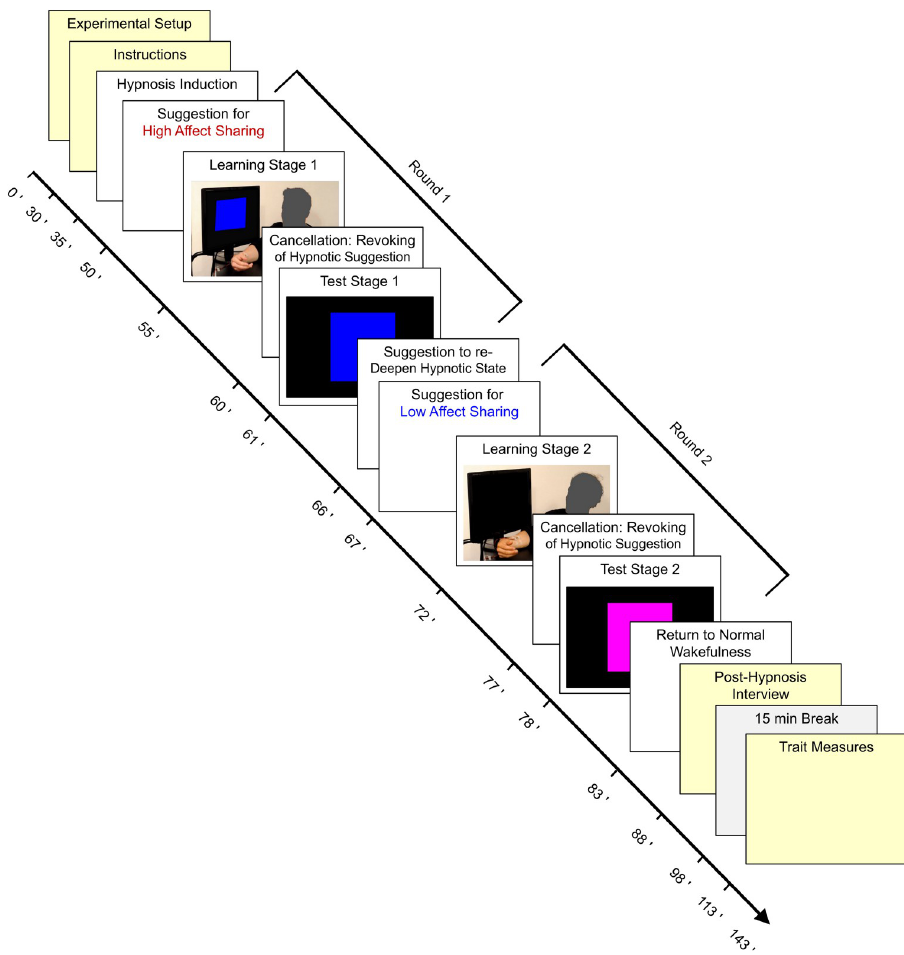
Fig 1. Overview of the experimental design and procedures. The vicarious fear conditioning paradigm consisted of a learning stage, in which the participant watched videos of a demonstrator receiving electric shocks paired with a predictive visual cue, followed by a test stage, in which an increased skin conductance response (SCR) to the cue compared to a control stimulus, in the absence of the demonstrator, indexed vicarious fear learning. Each participant completed this paradigm under two different hypnotic suggestions, which were administered before each learning stage to induce high or low affect sharing with the demonstrator (order counterbalanced across participants). Each suggestion was revoked (so-called “cancellation”) after the learning stage to bring the participants back to their habitual level of affect sharing before the start of the test stage. Eye tracking was used to assess eye gaze during the learning stages. The demonstrators’ heads have been masked in this Figure to protect their identity; participants saw their full face and expressions. a shock to the demonstrator (the demonstrator’s calm face following a CS- signaled the absence of the US). The videos are a well-tested stimulus set, which has been successfully used in previous studies on vicarious fear conditioning [2]. Video clips were presented at approximately 23.8 x 13.6˚ visual angle. Each video clip (trial) had a total duration of 9 s and started with the presentation of the square for 6 s. Electric shocks were delivered to the demonstrator 5.5 sec after trial start and lasted for 100 ms, while the demonstrator’s facial response lasted for approximately 2 s. The single 9 s long video clips were divided by an inter-trial-interval (ITI) showing a white fixation cross on black back- ground, jittered to range from 8–12 s duration, resulting in a total trial duration of 19 s on average.